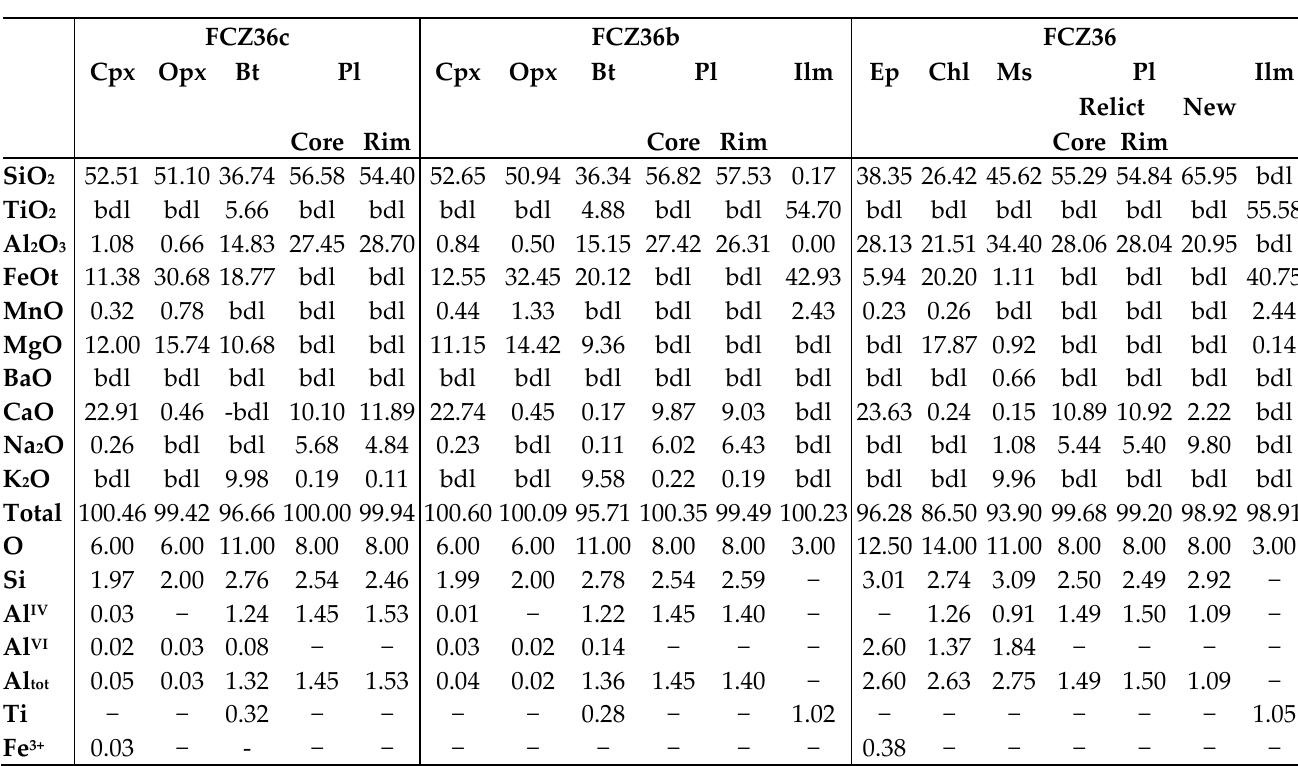
Table 3. Representative analysis of pyroxene, mica, plagioclase, chlorite, epidote and ilmenite composing metabasite samples; “bdl” is an abbreviation for “below detection